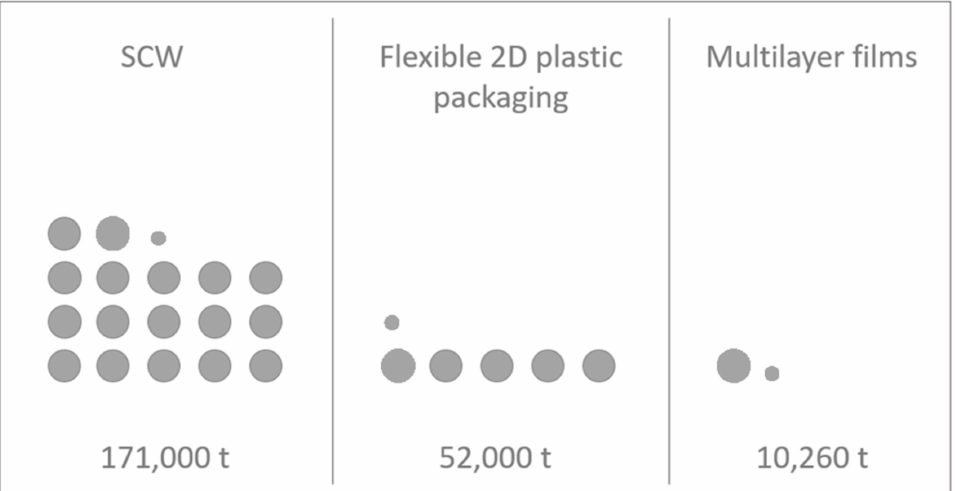
Figure 4. Graphical illustration of multilayer films compared to the Austrian separately collected waste (SCW) and flexible waste plastic